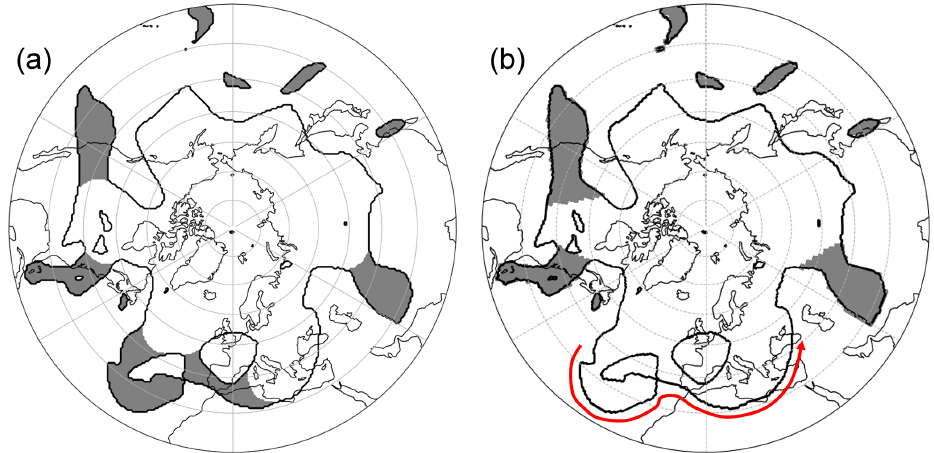
Figure 8. Same as Fig. 7 but with the data set used in Fig. 6. The red arrow indicates the outermost 2PVU contour, which is used to identify anomalies in the work by Wernli and Sprenger